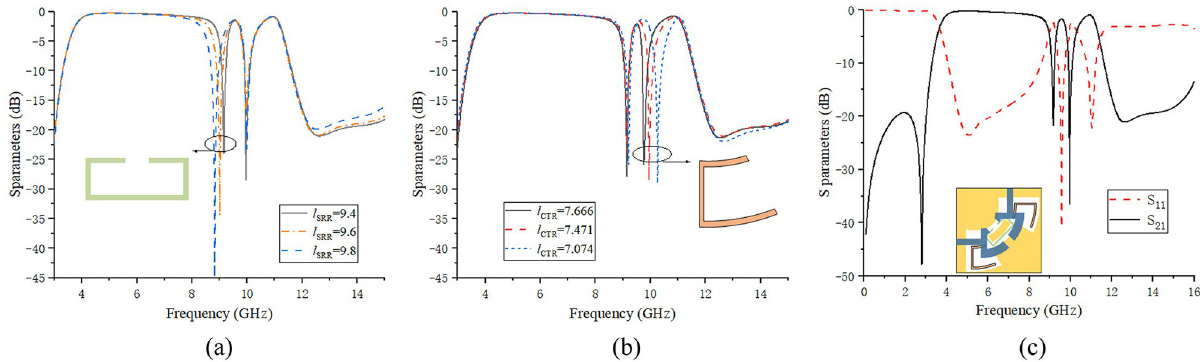
Fig 13. Notch characteristic analysis. (a) change the length of the SRR structure. (b) change the length of the CTR structure. (c) S 21 waveform of the double-notch UWB BPF.